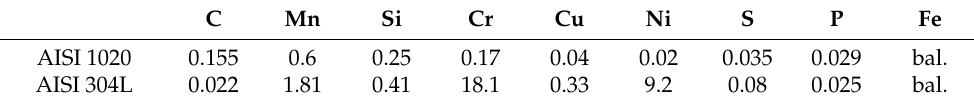
Table 1. Base metals chemical composition (wt%).